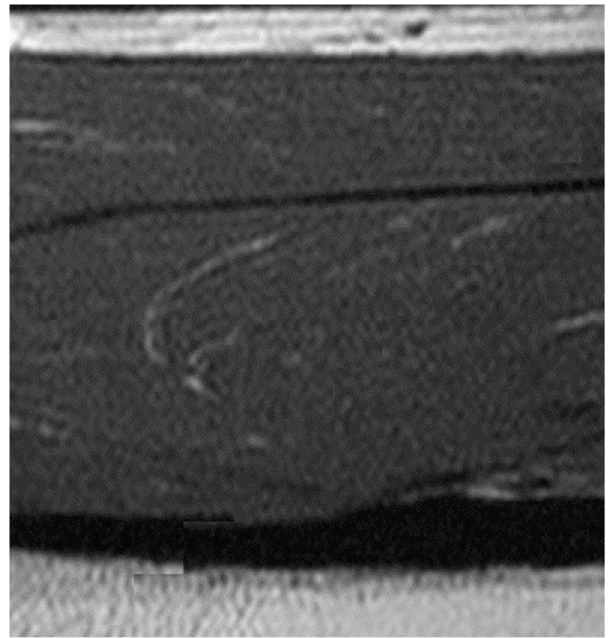
Figure 5. An example of an MRI image of a human crus. The fat layer corresponds to the upper high- brightness region. The sound velocity in fat was measured in the central fat layer. The sound velocity in muscle was measured in the central muscle region between the bottom of the fat layer and the top of the fascia layer (lower-brightness horizontal stripe region).